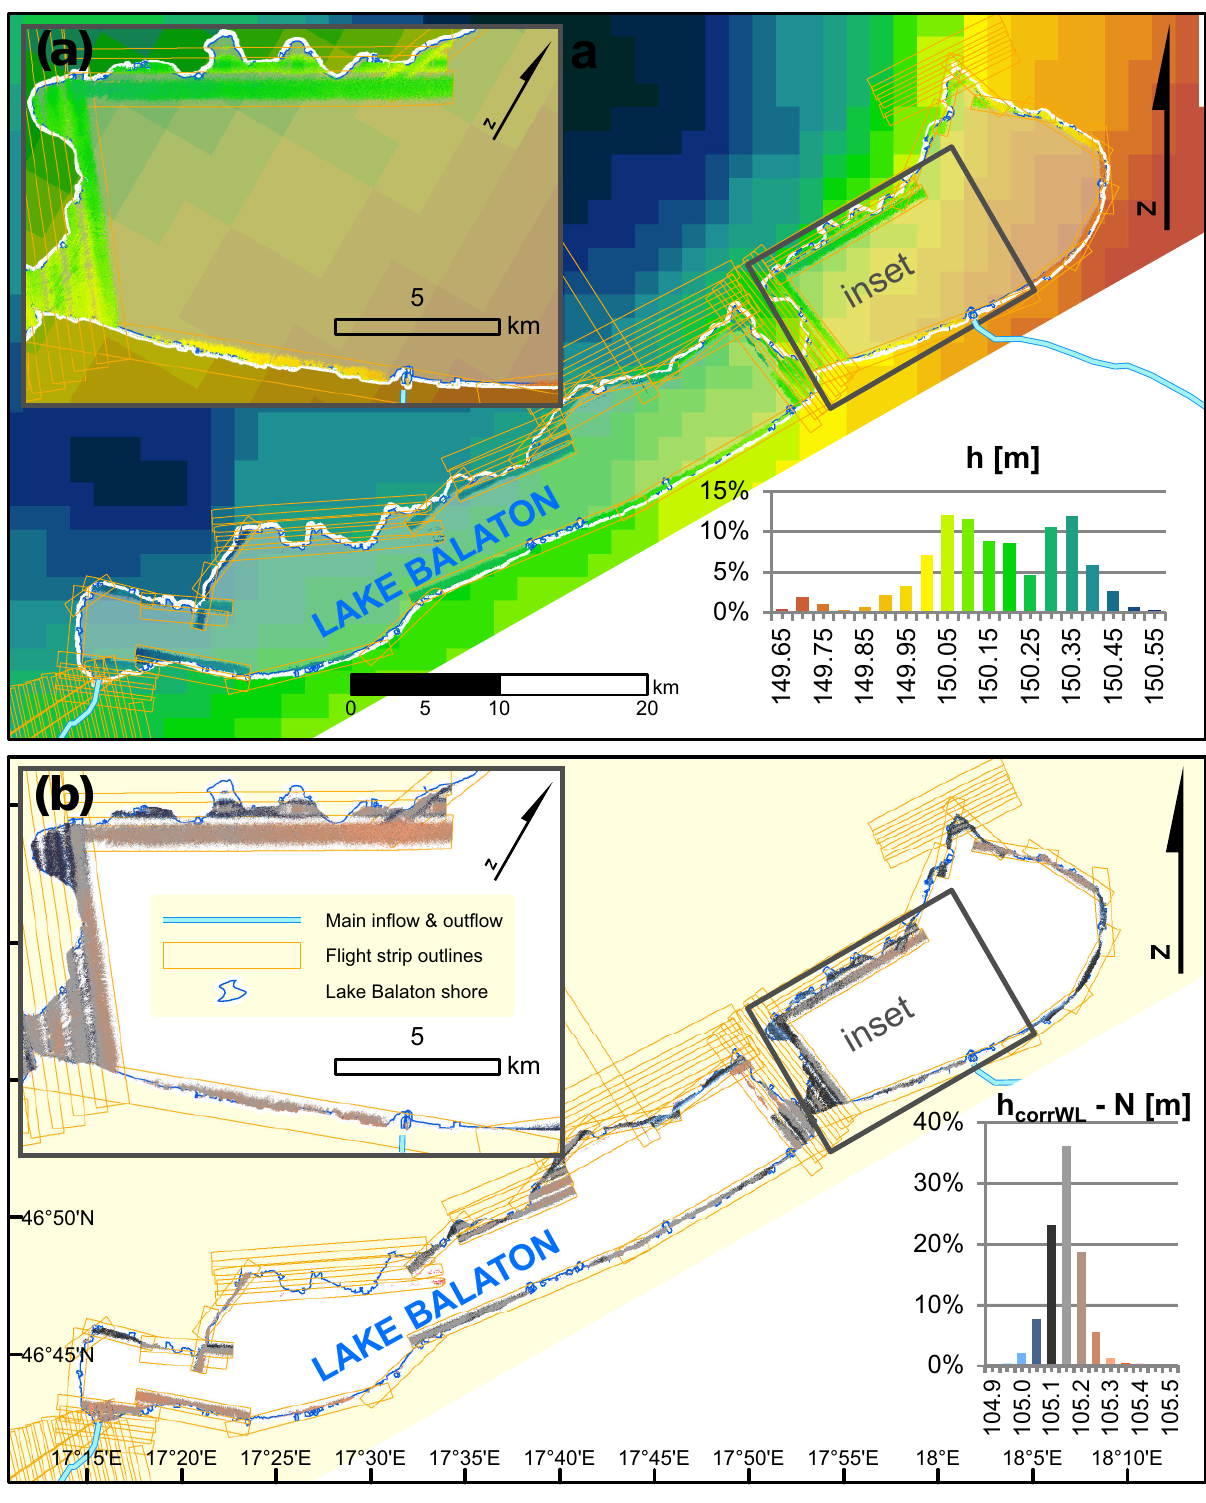
Figure 2. (a) Map of lidar-measured ellipsoidal water surface heights (inside flight strip outlines) and modeled gravity potential isosurface height (background raster) with the same elevation color scheme. Inset shows detailed height distribution of water surface measurements, histogram refers to lidar measurements (not to gravity potential isosurface model). (b) Map of lidar-derived normal water surface heights, obtained by correction with local deviation of LMLL and local quasi-geoid height. Histogram refers to water surface normal heights.